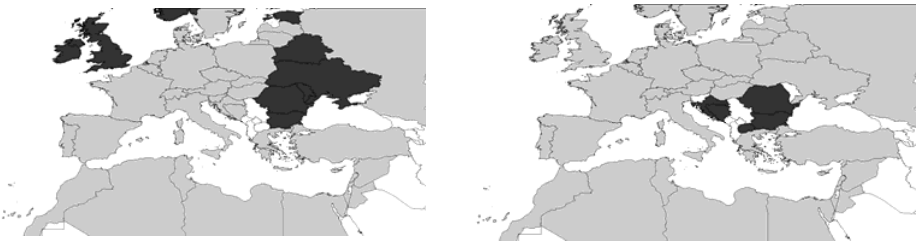
Figure 2. The geographical distribution of Ch. gressorius ( left ) and Ch. griseus ( right ) according to the database of Fauna Europaea [22,23]. Grey = present; black = absent, and white = no data.